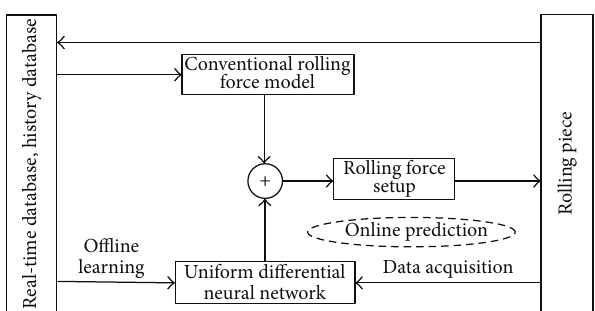
Figure 3: Application strategy of uniform differential neural net- work rolling force prediction